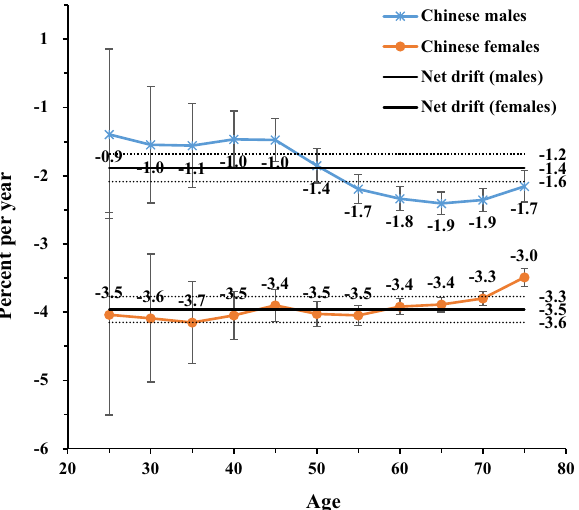
Figure 2. Local drift with net drift values for high SBP-attributable stroke mortality in China. Age group- specific annual percent change (local drift) with the overall annual percent change (net drift) in high sodium- attributable stroke mortality rate. Net drift values are depicted as solid lines with dashed lines representing their 95% CIs. Error bars represent the 95% CIs for the local drift values. Japanese men 1990: Population: 38 067